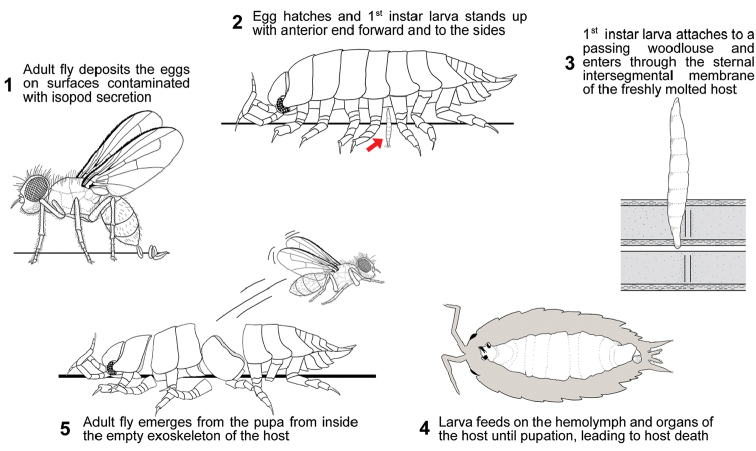
Schematic representation of the infection cycle of a Rhinophoridae fly in a woodlouse host. 3 is modified from Thompson (1934).